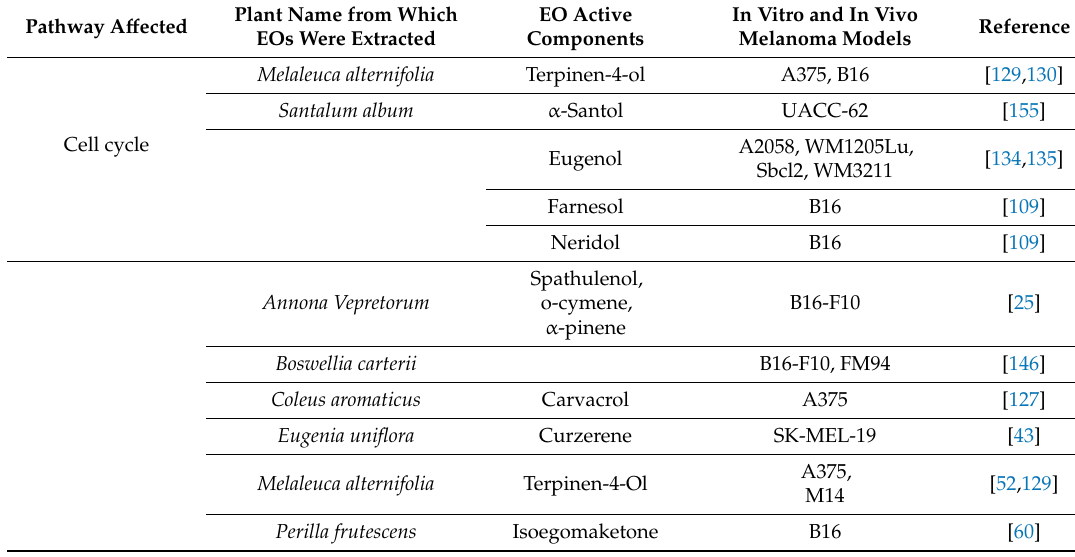
Table 3. EOs and their components that were demonstrated to a ff ect cell cycle distribution, apoptosis, necrosis and autophagy of melanoma